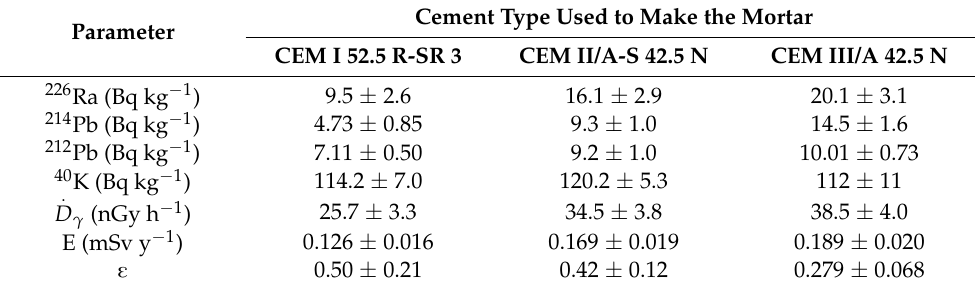
Table 4. Activity concentrations of 226 Ra, 214 Pb, 212 Pb, 40 K, absorbed dose ( and 222 Rn emanation rate for the three tested